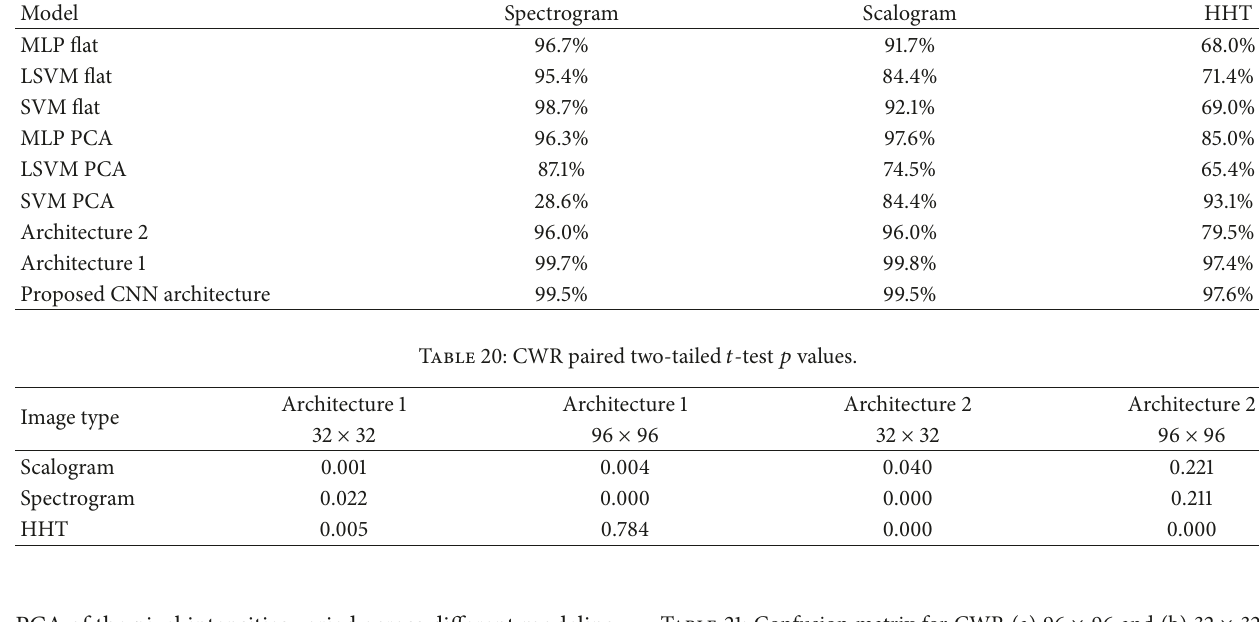
Table 21: Confusion matrix for CWR (a) 96 × 96 and (b) 32 × 32 scalograms for the proposed